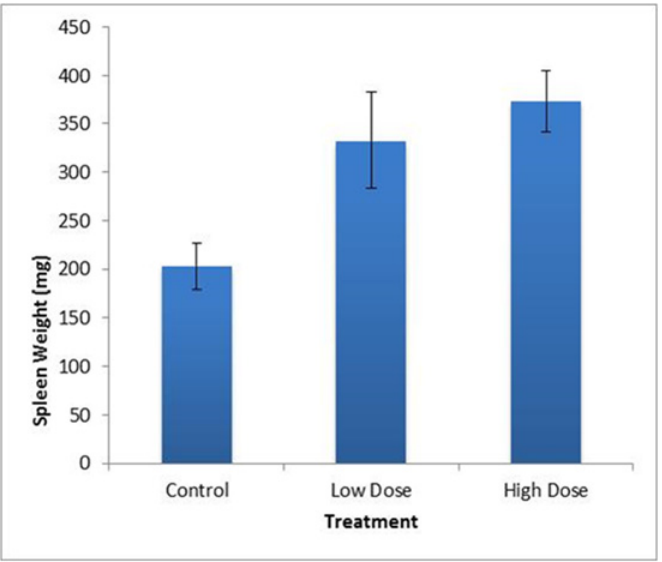
Fig 1. Mean spleen weights (g) of control, low dose and high dose rats. Mean spleen weight of the HD was significantly greater ( p = 0.011, F = 5.92. DF = 2) than the uninfected controls. Mean spleen weight of control rats was 202.8 mg, of LD rats was 332.9 mg and of HD rats was 373.3 mg. Standard error bars are indicated.